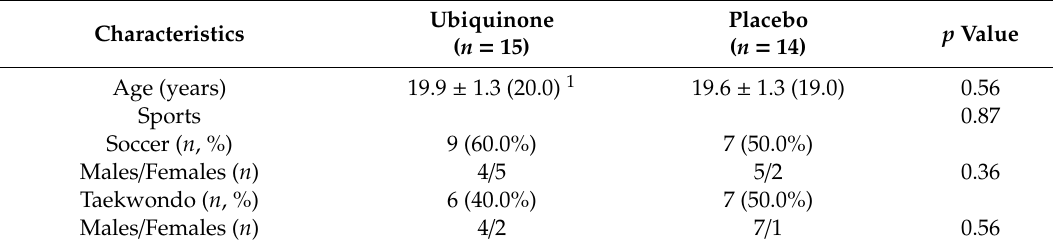
Table 1. Characteristics of subjects at